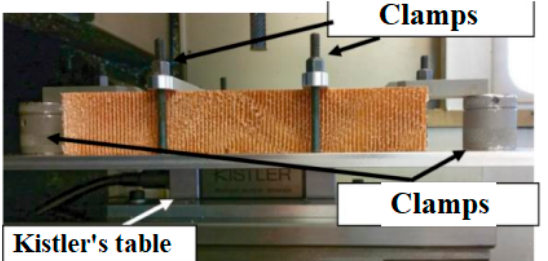
Figure 3. Experimental milling setup of the Nomex honeycomb structure [23].